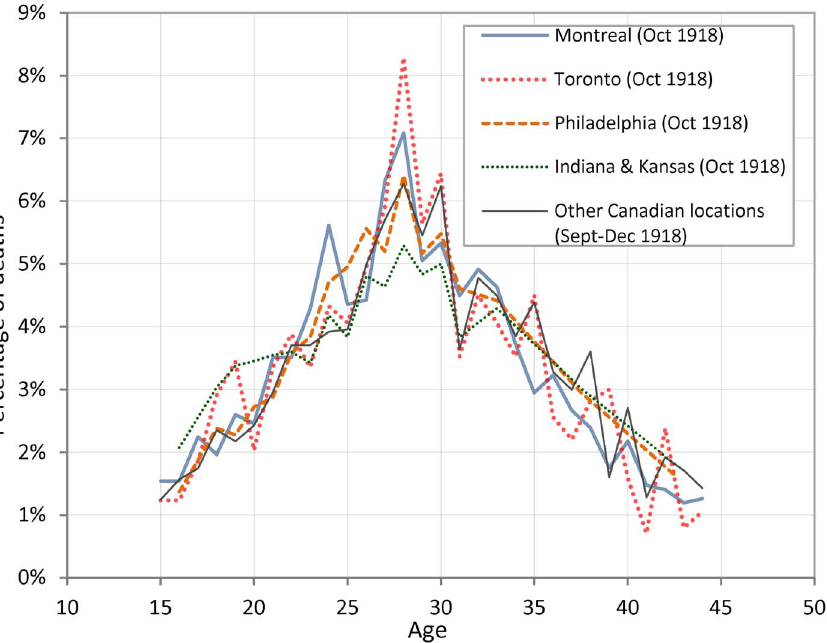
Figure 3. Distribution of deaths (from all causes) by age as a percentage of all deaths between ages 15 and 44 in all available Canadian and American locations. * *Key for Figure 3: Yearly age-specific death counts were available from age 18 to 31 for Philadelphia, Indiana, and Kansas in the special tables that were tabulated for these locations in 1920 (27); Outside this range, death counts were only available for collapsed age-groups (i.e., 15–17, 32–34, 35–39, and 40–44). For these age-groups we divided the number of deaths in the interval by its length and plotted the obtained number at the midpoint value of the interval. Other Canadian locations: Hamilton, Ottawa, London, Welland & Lincoln, Winnipeg, and Vancouver.